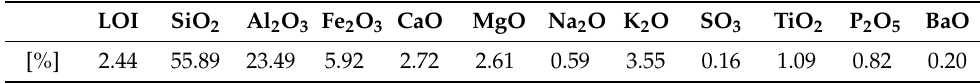
Table 2. Oxide composition of fly ash.